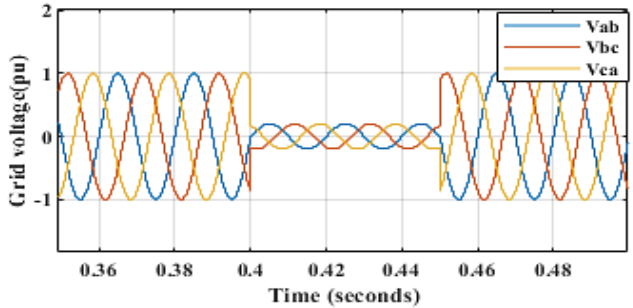
Figure 17. Grid voltage of the DFIG system under scenario II.